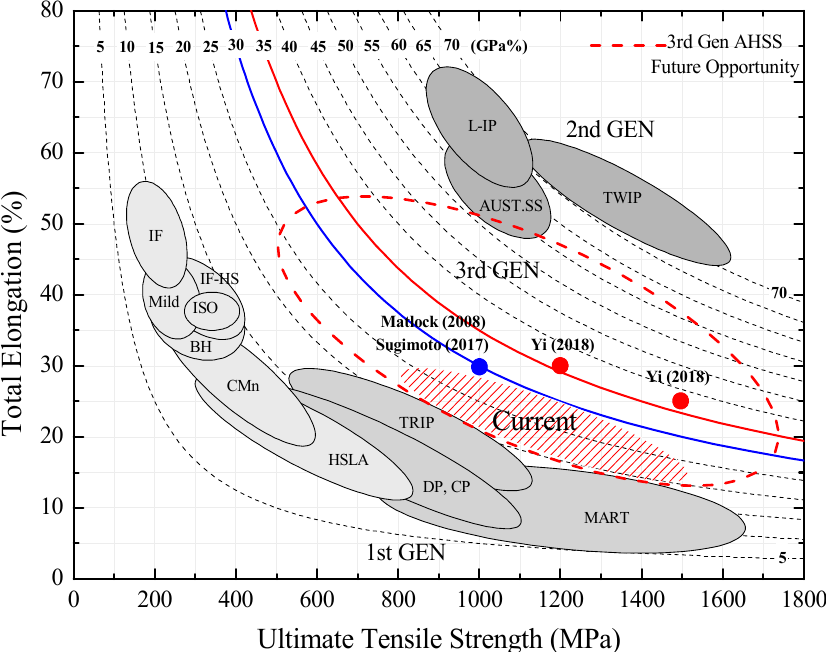
Figure 1. Global formability diagram of various automotive steels: the future opportunity and classifications of the third generation of AHSS. Adapted from [4,8,9].